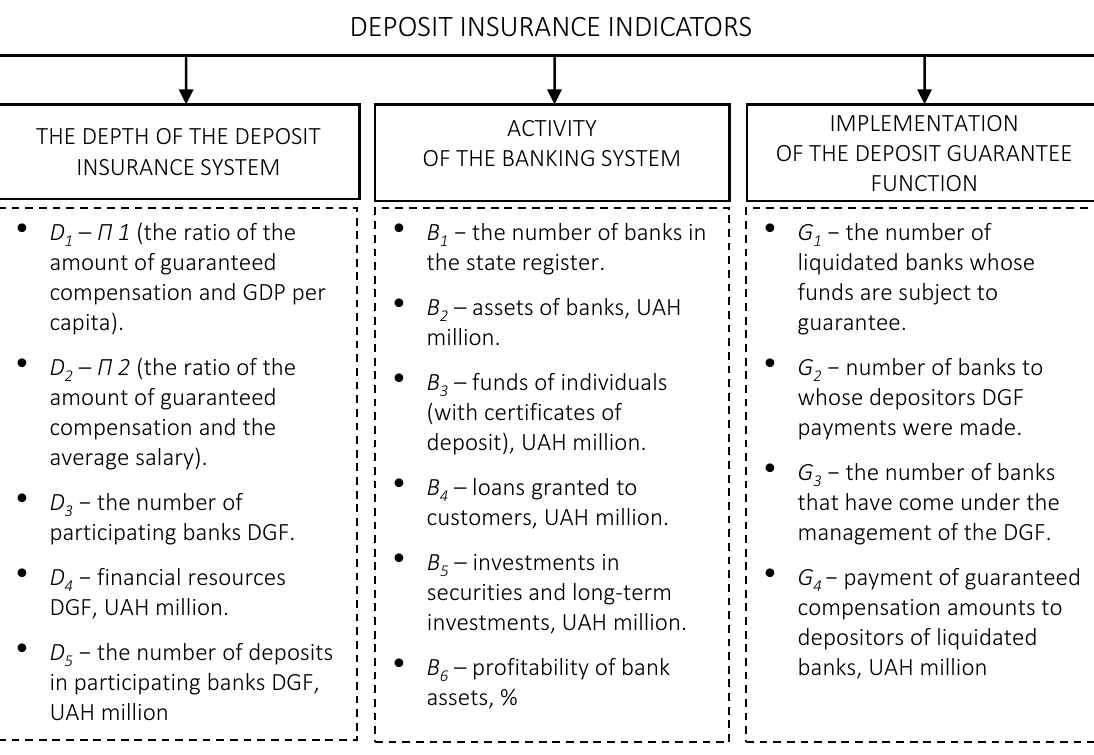
Figure 1. Indicators selected for periodization of the development of deposit